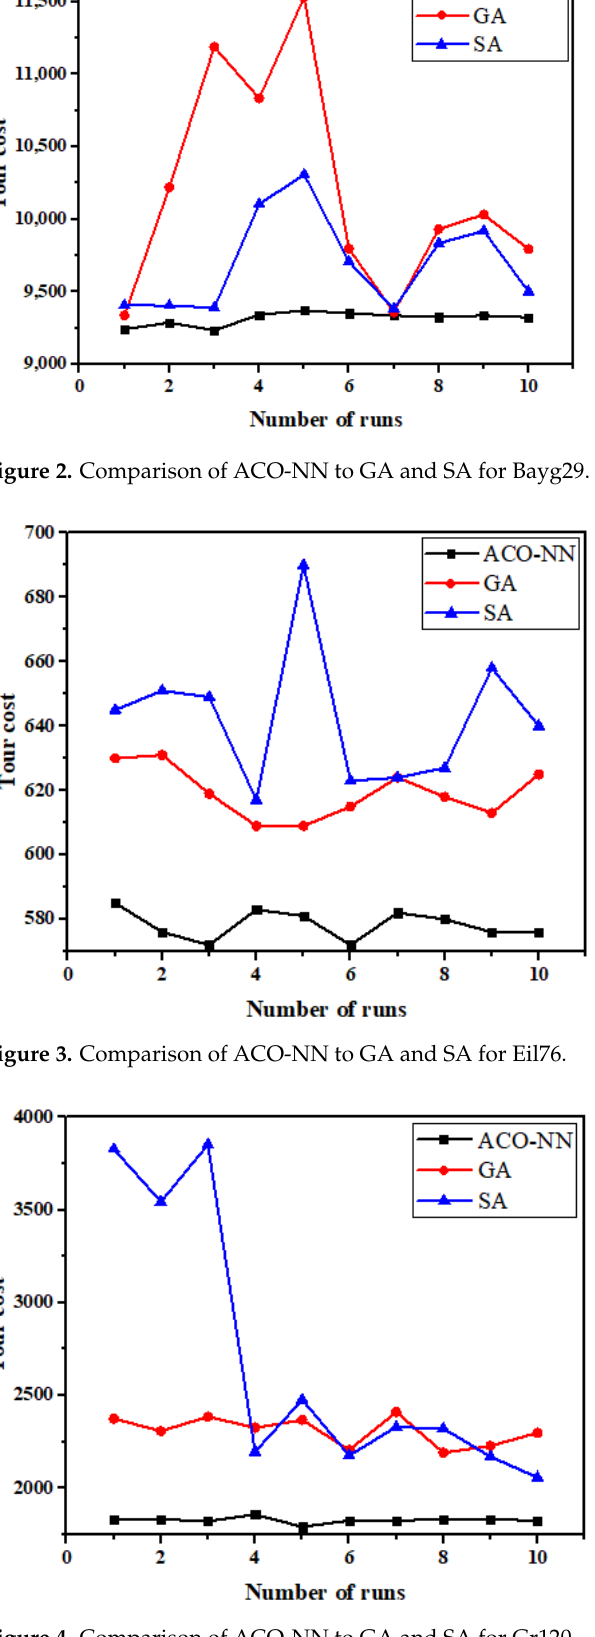
Figure 4. Comparison of ACO-NN to GA and SA for